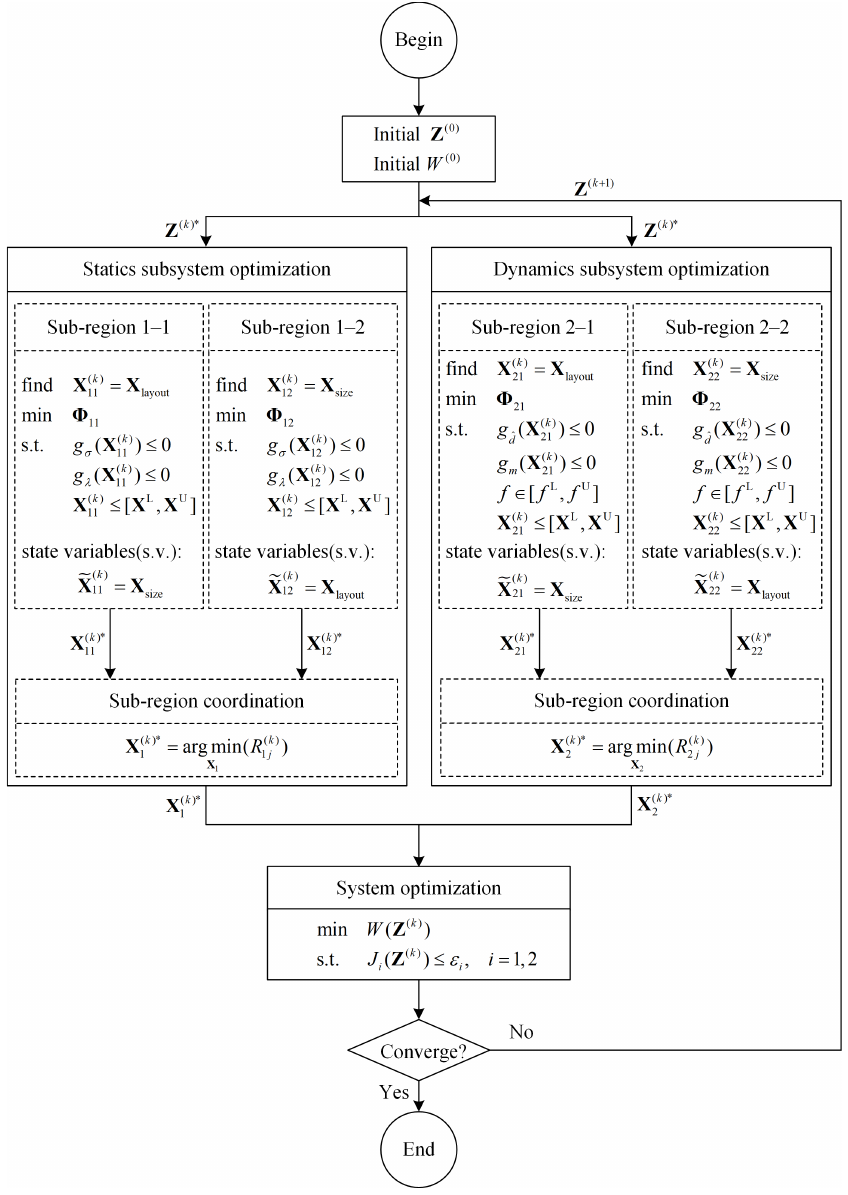
Figure 3. Flowchart of CSRC